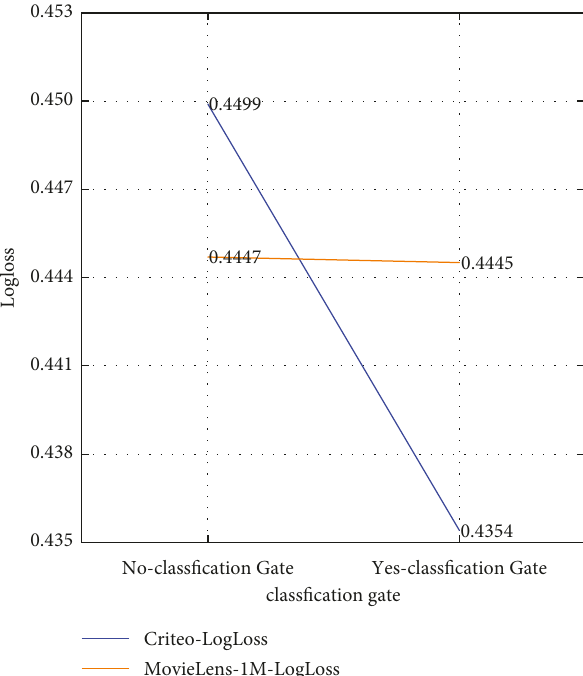
Figure 14: The Combine layer of Logloss in model